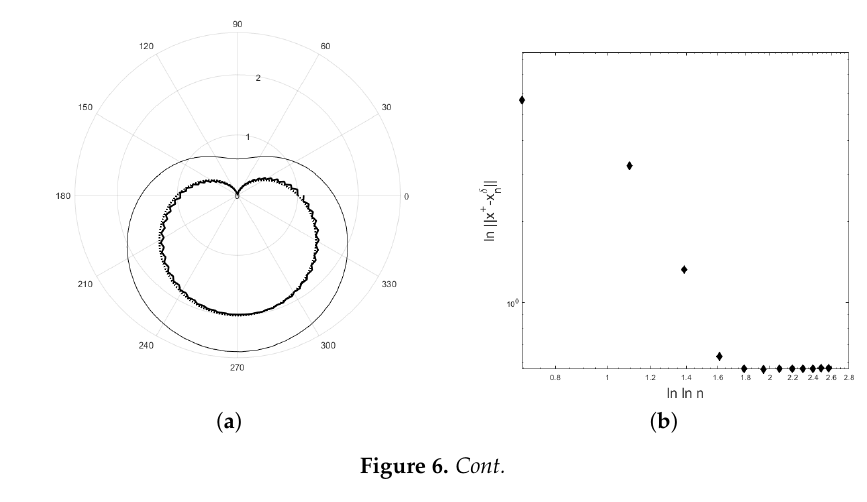
versus the logarithm of the number x + x δ n (cid:107) − (cid:107) ( 100 + n ) − 0.9 . 2